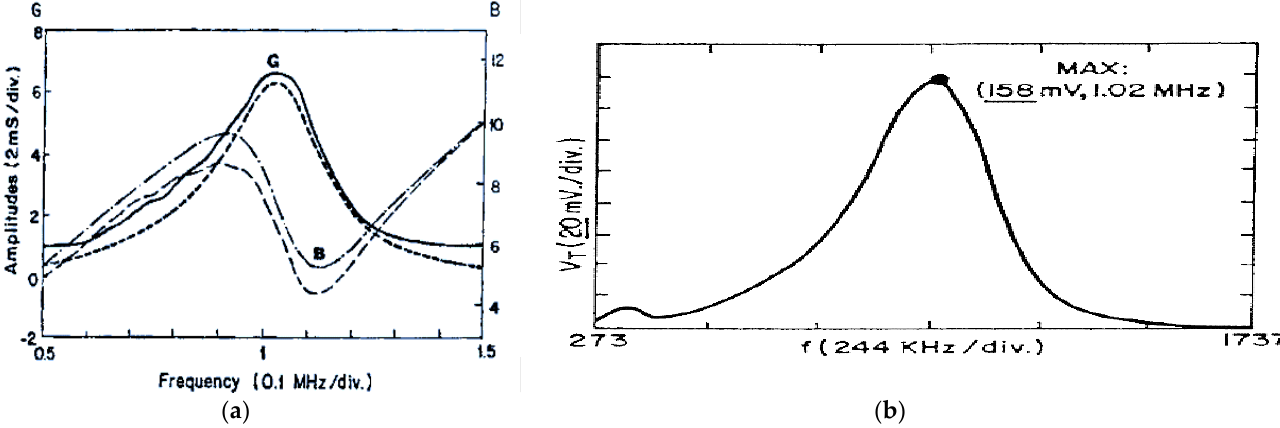
Figure 10. ( a ). Measured frequency spectra of real (G) and imaginary (B) parts of the electrical admittance in the untuned Q269 broadband transducer. ( b ) Experimental basic frequency band of the received signal in a Q270 transducer, connected in a through-transmission scheme, without any inductive tuning in either stage, and when Q269 is driven by our HV capacitive driver.